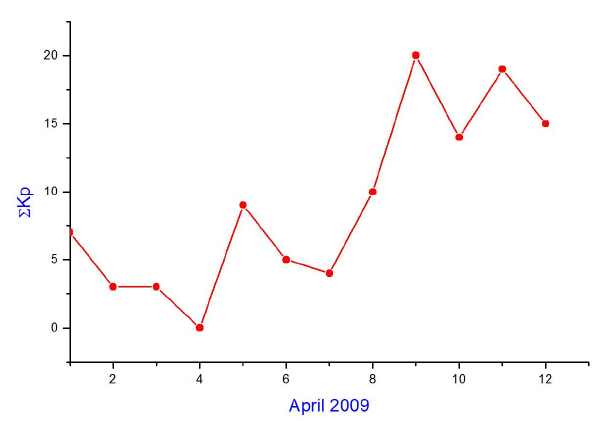
Fig. 12. Diagram of the Kp index during the L’Aquila earthquake Fig.12 diagram of the Kp index during the L'Aquila earthquake sequences sequences.